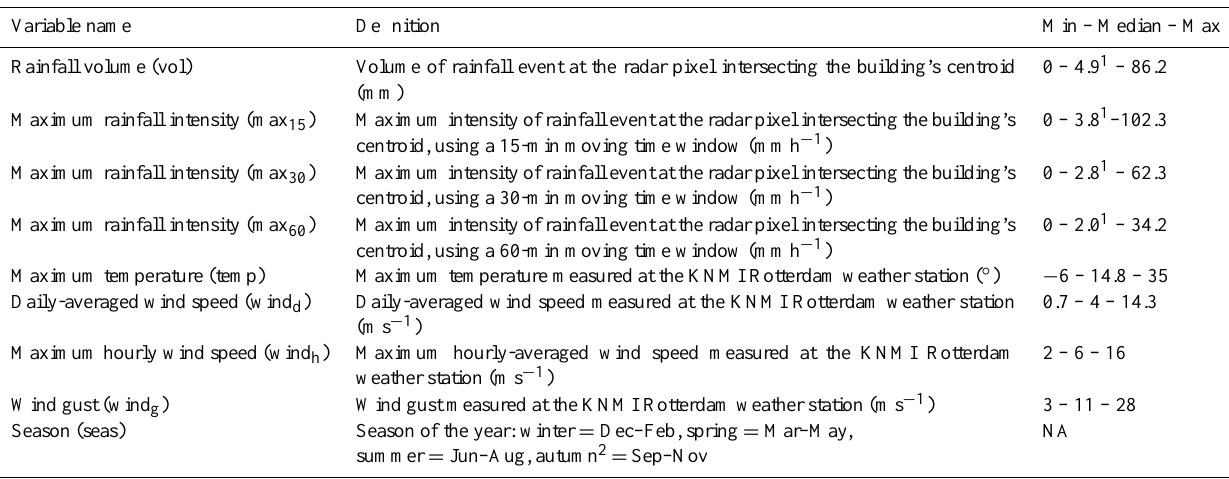
Figure 1. Water-related failure mechanisms applicable to residential buildings. A situation with a combined sewer system is depicted. Descriptions of the numbers are listed in Table 3. Table 4. Definitions of explanatory variables and variable value